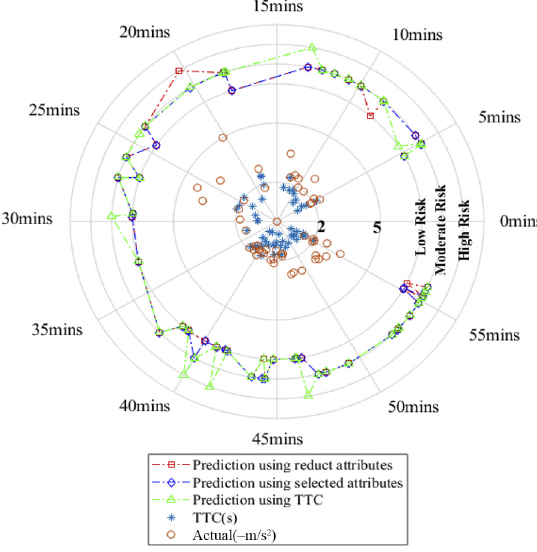
Figure 6 Results of vehicle collision risk prediction based on reduct attributes, selected attributes and TTC Figure 7 Results of vehicle collision risk prediction based on reduct attributes, collected attributes and selected